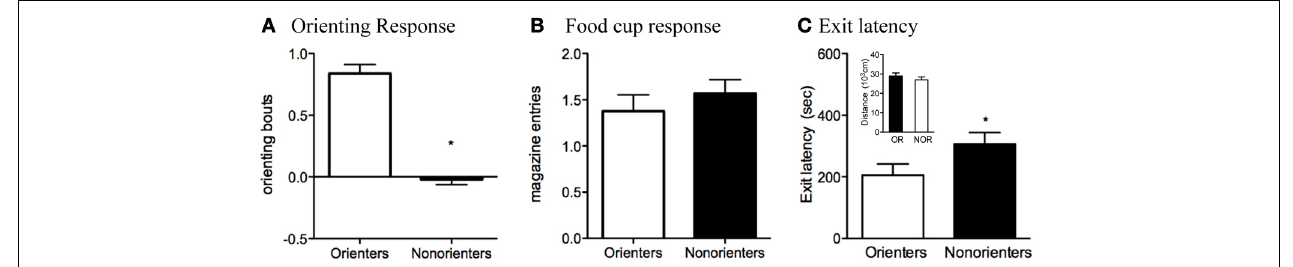
FIGURE 2 | (A,B) Conditioned orienting and food cup approach for the Orienters and Nonorienters. Mean ± s.e.m number of orienting bouts ( ∗ p < 0 . 0001) (A) or food cup entries ( p = 0 . 42) (B) averaged for last 8 trials of training. Orienters showed significantly more orienting than Nonorienters, but the food cup response was equivalent between